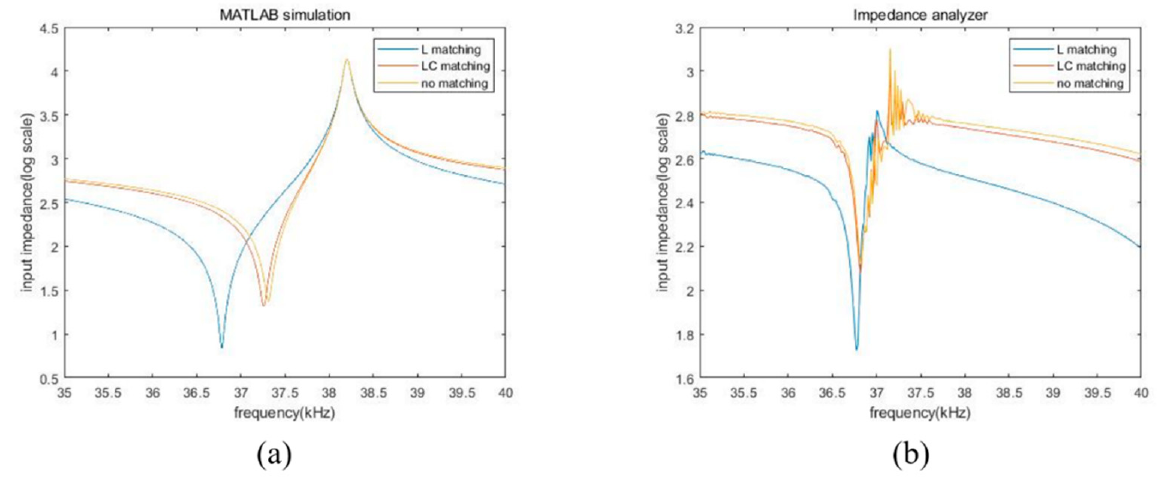
Figure 8. Comparison between simulation and experiment results. ( a ) MATLAB simulation, ( b ) impedance analyzer.